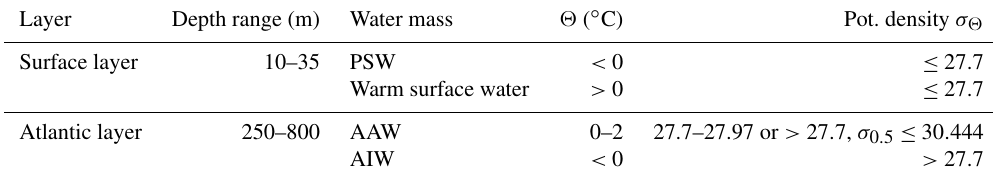
Table 1. Water masses and properties in the two layers that samples were clustered by in this study, following the definitions in Rudels et al.